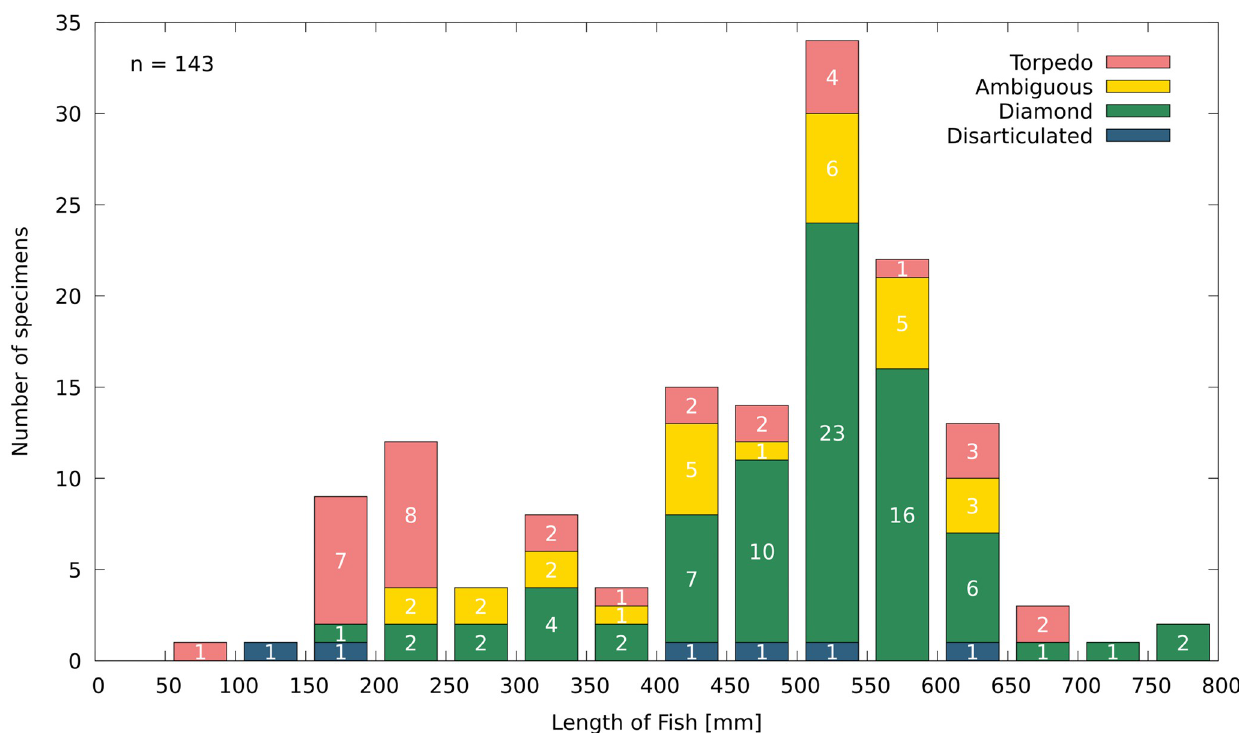
Fig 6. Size range distribution of 143 individuals of T . formosa from Vallecillo correlated to both body shape types. Torpedo-shaped individuals are marked in red and diamond-shaped specimens in green. Disarticulated individuals are presented in blue and ambiguous individuals in yellow.